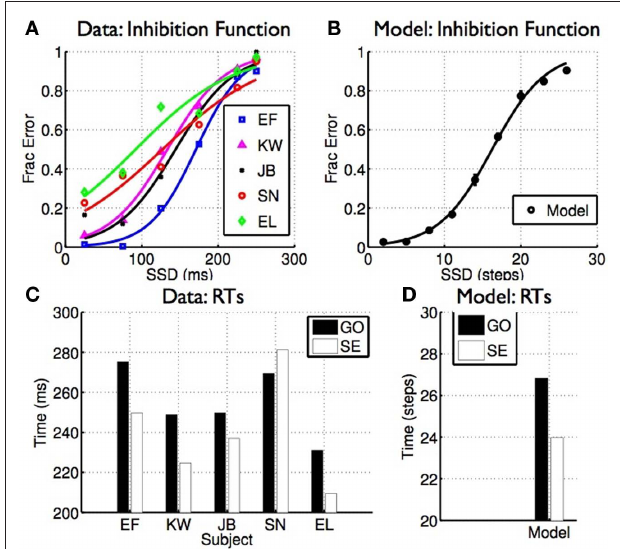
Figure 5 | Classical properties of stopping behavior arise naturally from optimal decision-making. (A) Inhibition function: errors on stop trials increase as a function of SSD. (B) Similar inhibition function seen for the model. (C) Discrimination RT is generally faster on stop error trials than go trials. (D) Similar results seen in the model. (A,C) Data adapted from Emeric et al. (2007) with permission